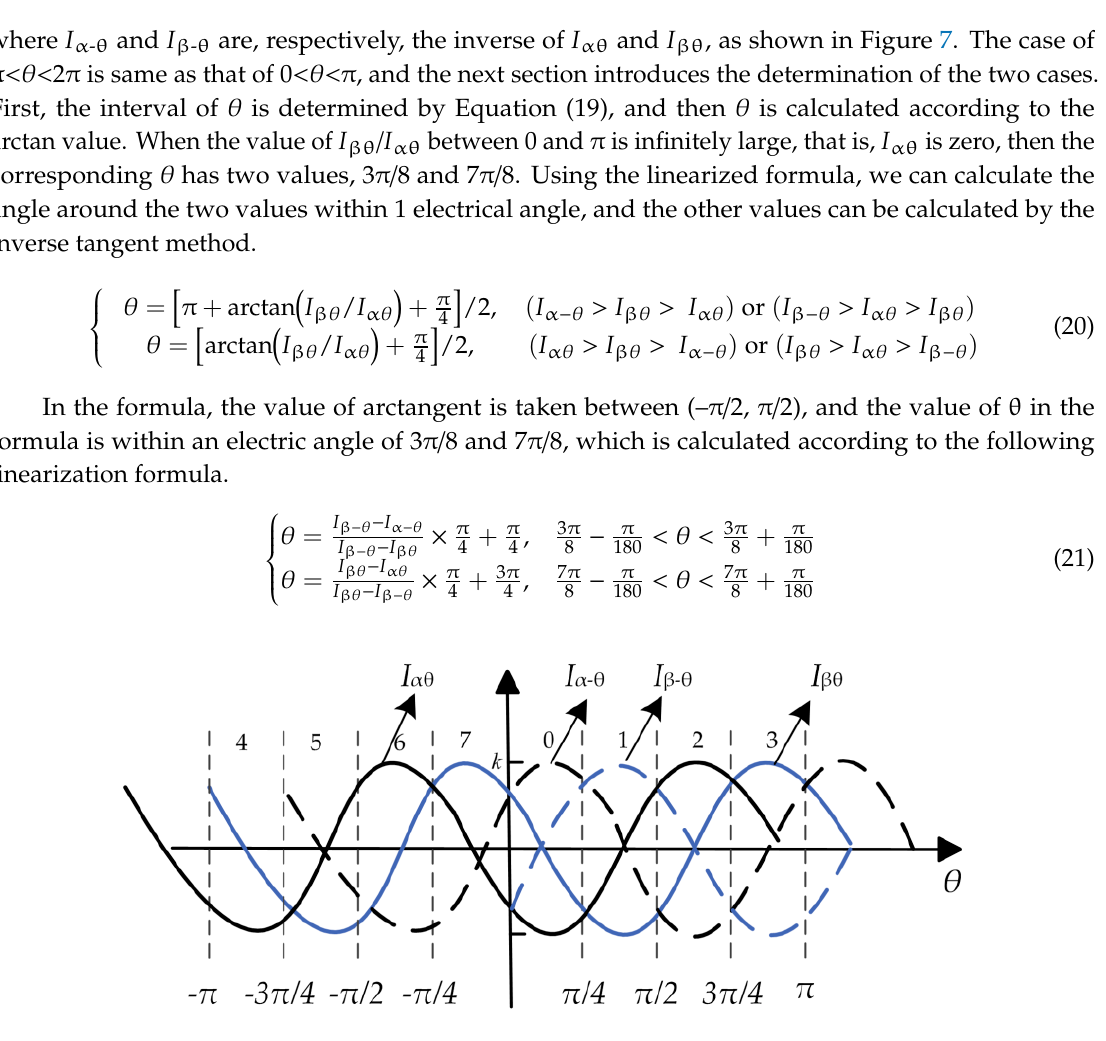
Figure 7. Amplitude of high-frequency current and its reverse.